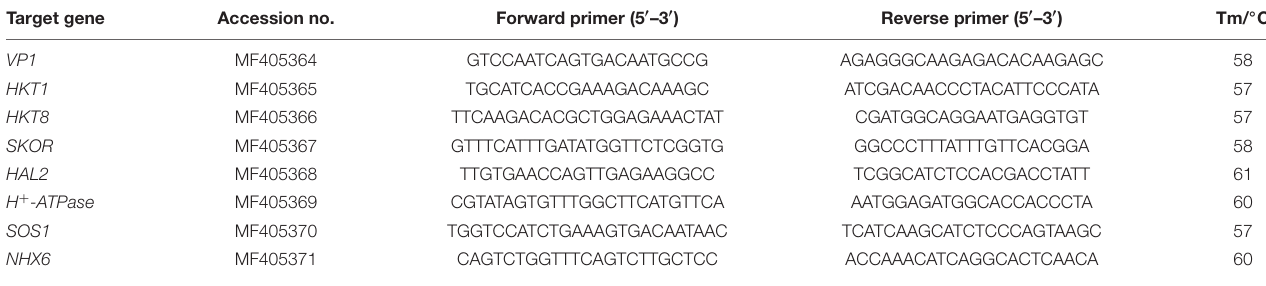
TABLE 1 | Primer sequences and their corresponding GeneBank accession numbers of analyzed genes. Target